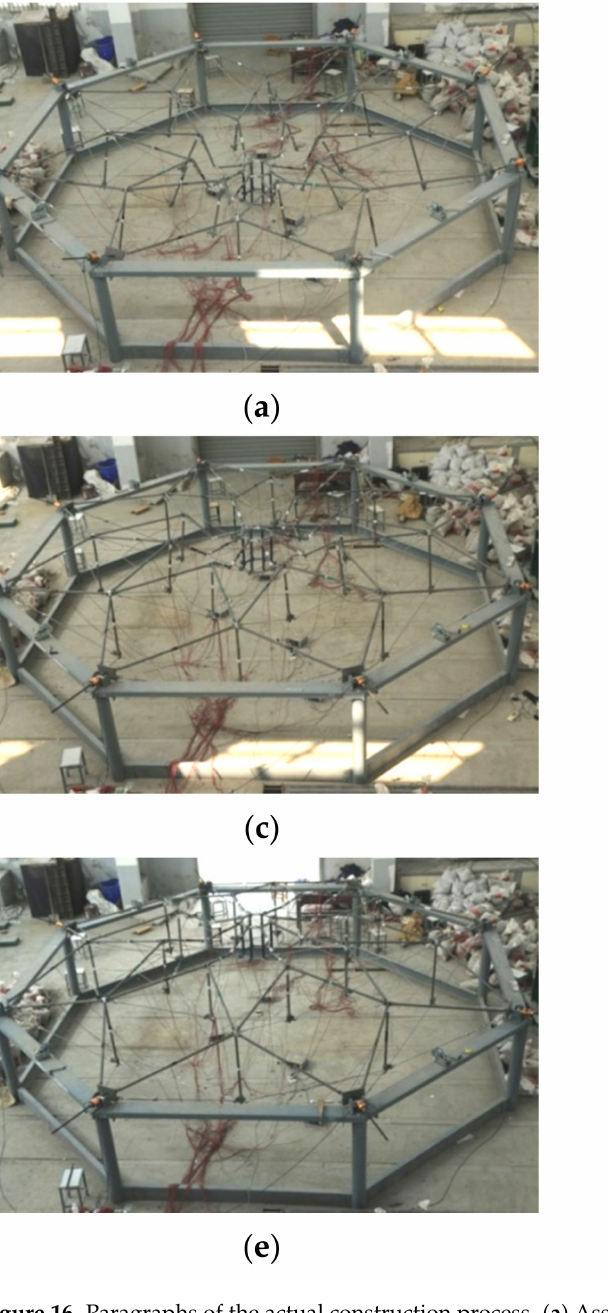
Figure 16. Paragraphs of the actual construction process. ( a ) Assemble the specimen components at the test site; ( b ) Adjust the lengths of the adjustable screw; ( c ) Finish the traction and lifting process; ( d ) Adjust the lengths of basket screws; ( e ) Mold the entire structure; ( f ) Fine-tune the